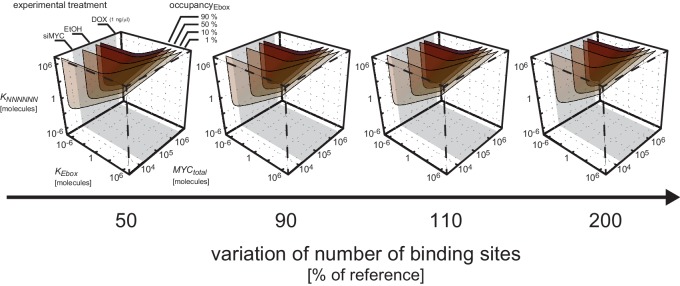
Impact of number of E-boxes and NNNNNN sequences.Different combinations of number of E-boxes and NNNNNN sequences are assumed in the simulations: [Eboxtotal]=9.3⋅105 and [NNNNNNtotal]=9.5⋅109 represent the reference values and the range of 50% to 200% of these reference values is taken into account. Surfaces of equal occupancy of E-boxes are shown as function of dissociation constants KNNNNNN and KEbox as well as total amount of MYC.